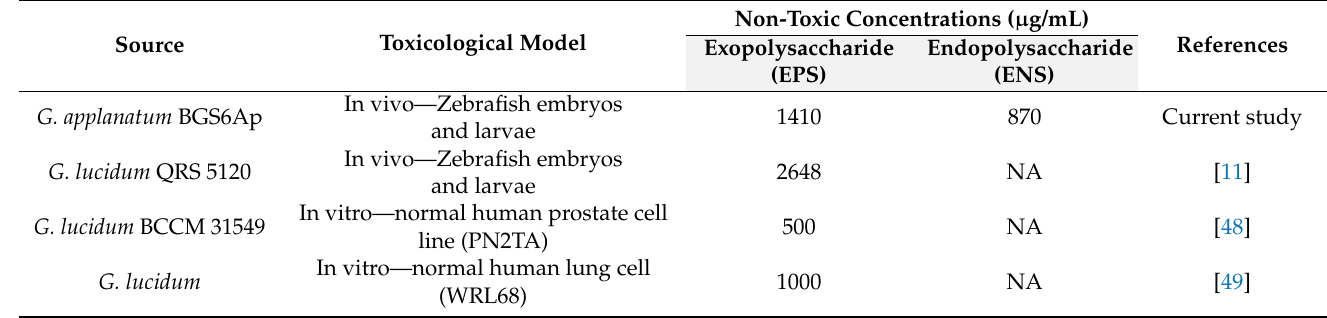
Table 1. Comparison with published non-toxicity assessment of exopolysaccharide (EPS) and endopolysaccharide (ENS) from the mushroom Ganoderma